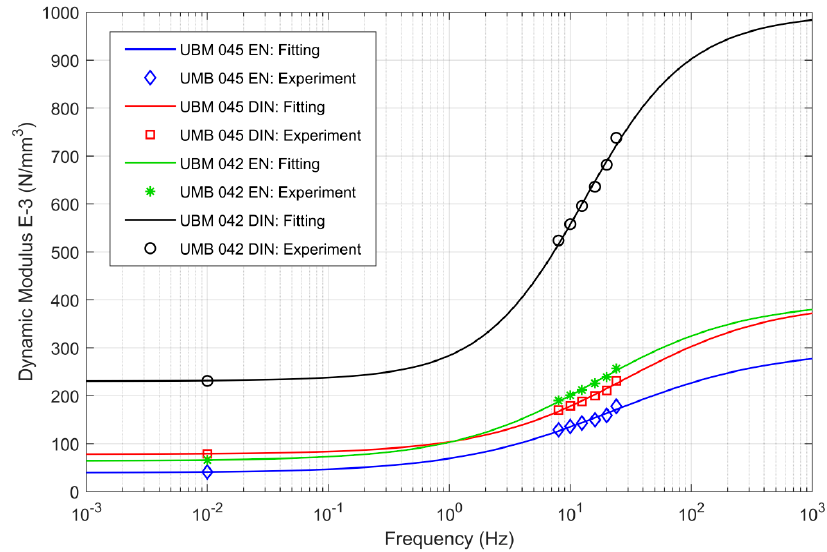
Figure 10. Complex plane characteristics of UBM modeled with Kelvin–Voigt and fractional zener model.